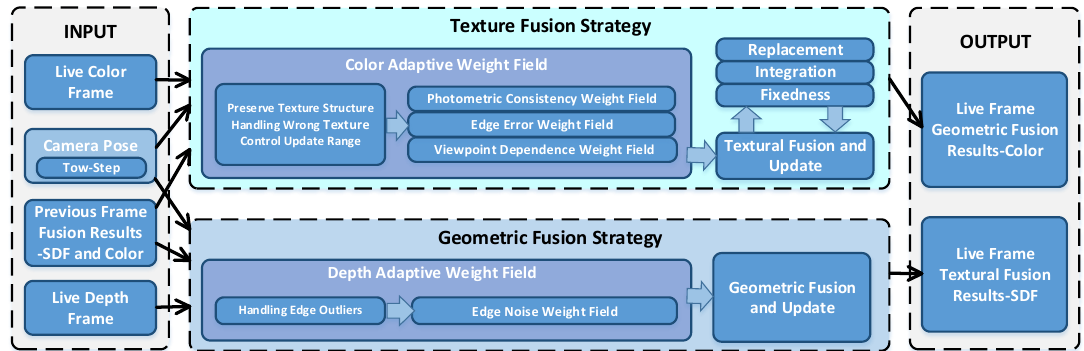
Figure 3. The specific pipelines for our new volumetric fusion strategy. We use the same input and output as the classical volumetric fusion method, and use different fusion strategies for geometric fusion and texture fusion respectively. For texture fusion strategy, we first establish an adaptive weight field to evaluate the confidence of the data and then use different operations to update the texture.